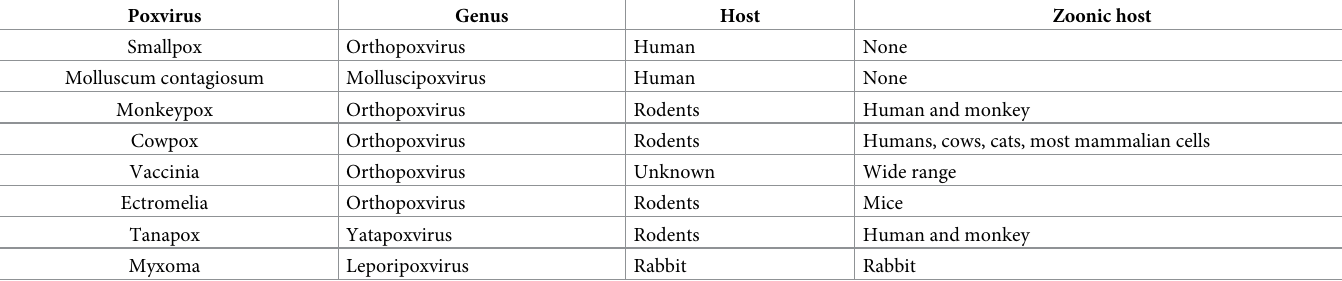
Table 2. The host range of